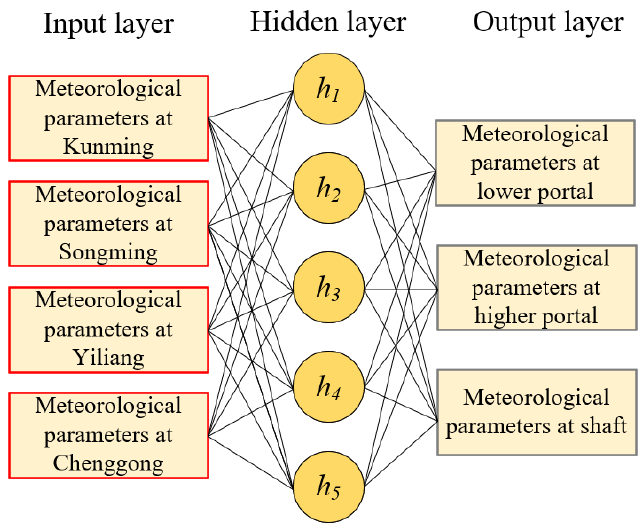
Figure 3. Multi-layer perceptron structure for real-time data acquisition.